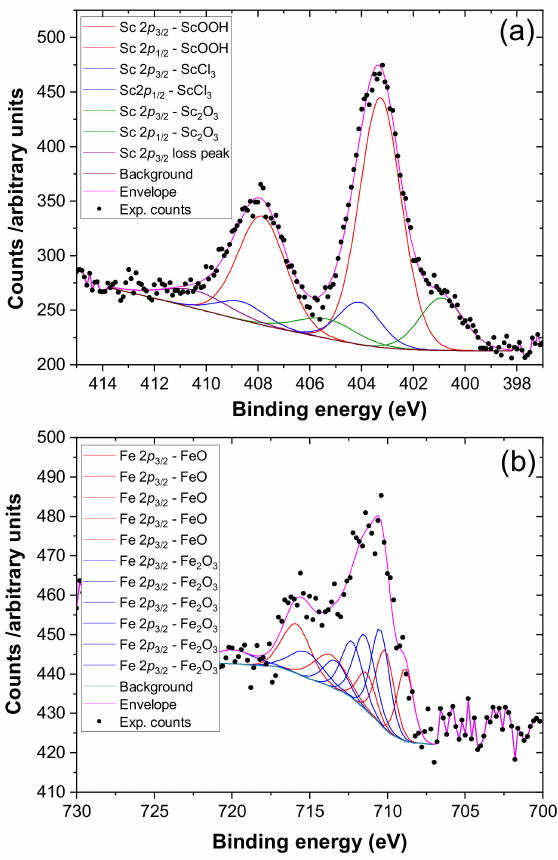
Figure 7. X-ray photoelectron spectra of MIL-88B(Fe,Sc) in ( a ) the Sc 2 p region and ( b ) the Fe 2 p 3 / 2 region. The fitted contributions are shown with reference spectra in the literature used for guidance (see